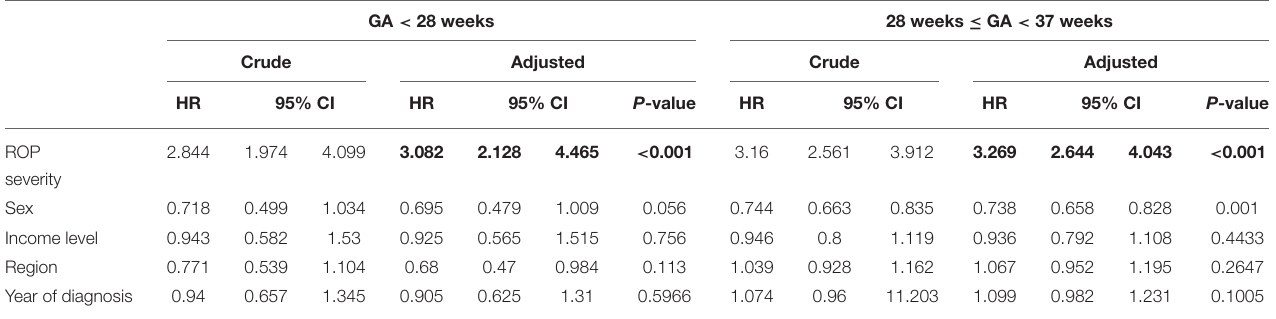
TABLE 2 | Crude and adjusted hazard ratios of neurodevelopmental complications according to retinopathy of prematurity severity, sex, and income level during the 10-year follow-up of premature infants. GA < 28